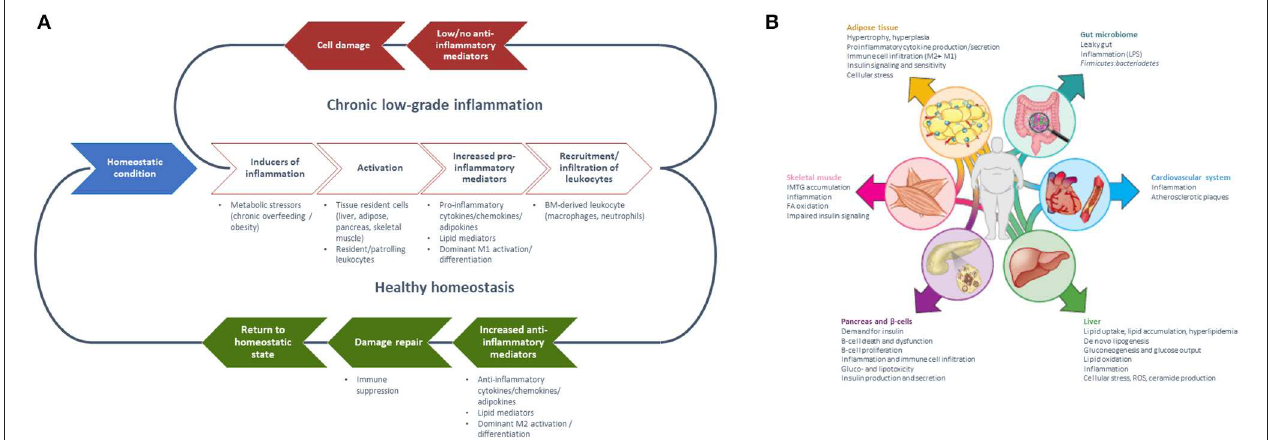
FIGURE 1 | (A) Generalized model of sequential steps involved in the inflammatory response in metabolic tissues resulting in chronic low-grade inflammation or return to a healthy homeostatic condition [inspired by Villeneuve et al. ( 17)] and (B) Manifestation of chronic low-grade inflammation in the different metabolic tissues [Reprinted with permission from Ralston et al.